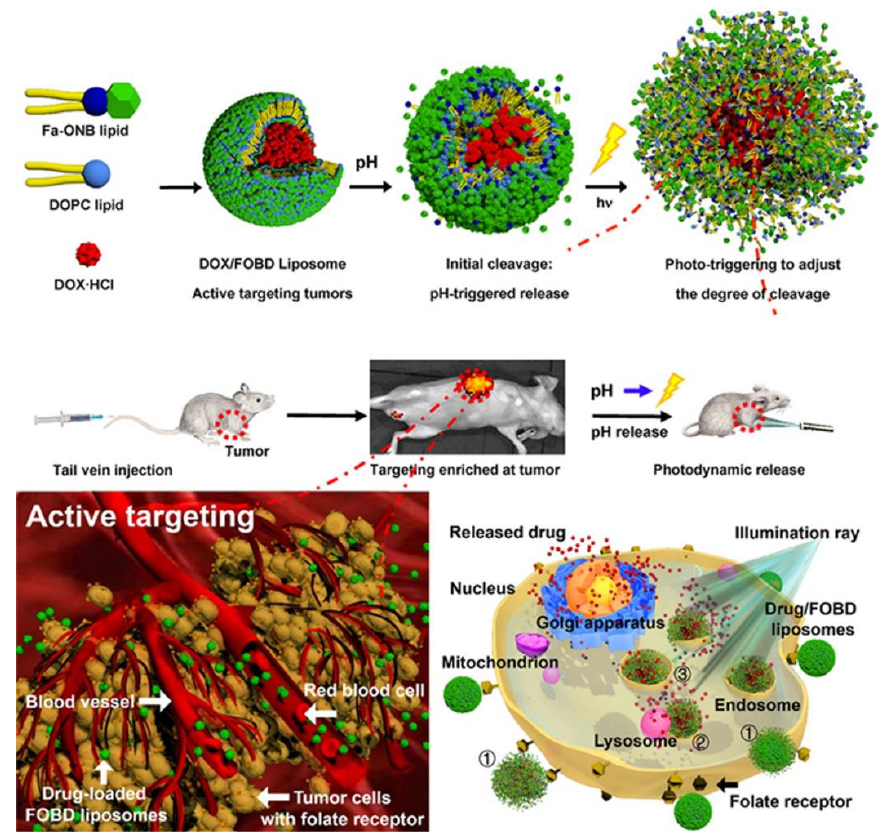
Figure 14. Schematic depiction of FOBD liposomes for active targeting and controlled drug release. Reproduced from [173] with permission, copyright 2020, American Chemical Society.